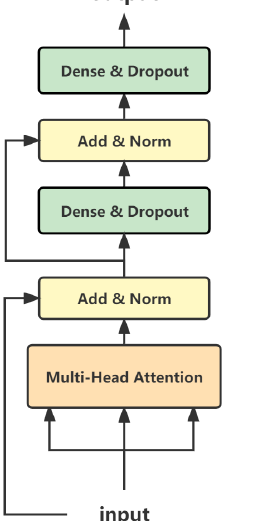
Figure 3. The architecture of